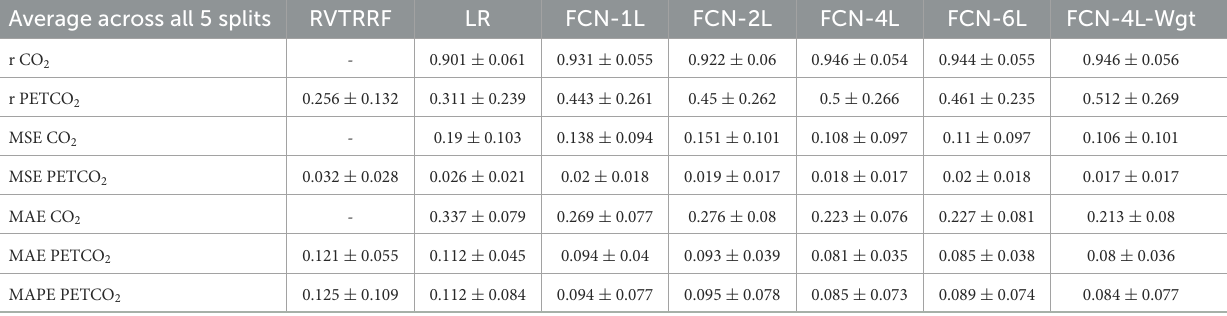
TABLE 1 Quantitative assessment of various approaches and network structures. Average across all 5 splits